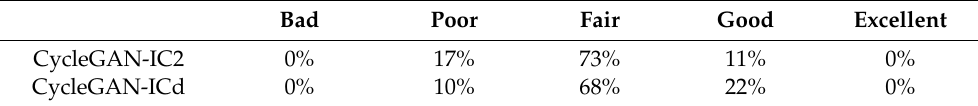
Table 8. The percentage distribution of MOS in singing to viola. Bad Poor Fair Good